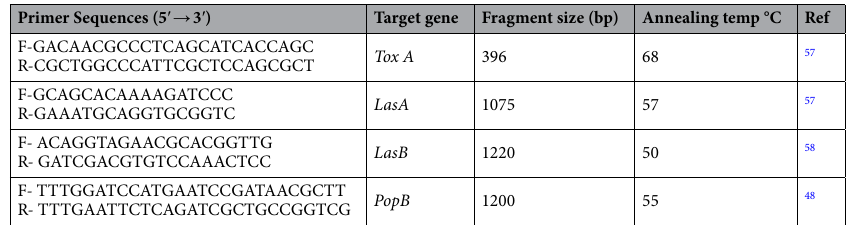
Table 6. Oligonucleotide primers used in the detection of virulence genes for P. aeruginosa.